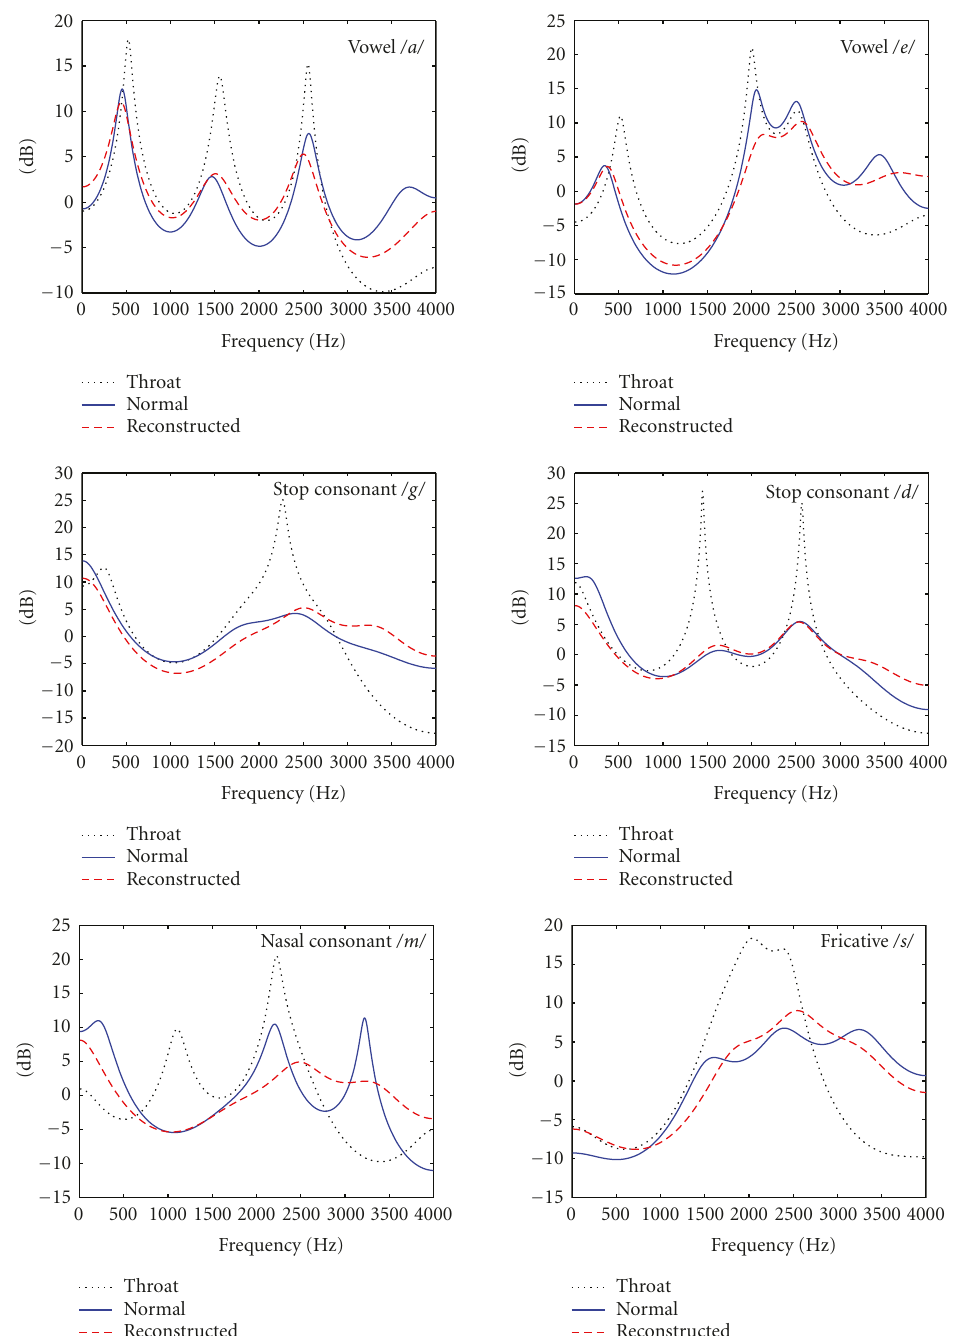
Figure 4: The LP spectra of the TM speech and the NM speech, and the estimated LP spectra, for the sound units /a/ , /e/ , /g/ , /d/ , /m/ , and /s/